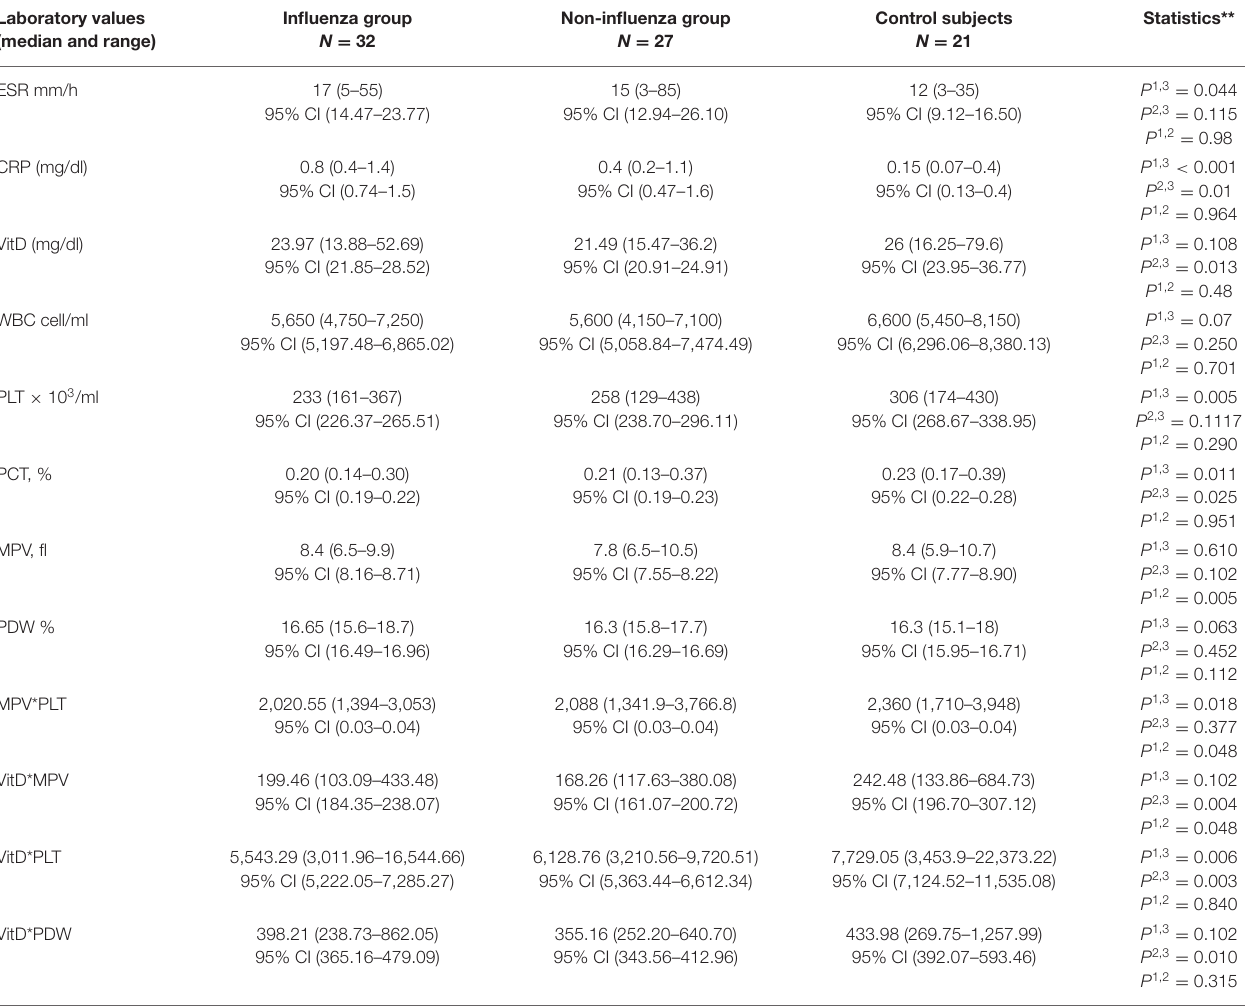
TABLE 2 | The laboratory values of children attending the emergency department with respiratory symptoms and healthy control subjects. Laboratory values (median and